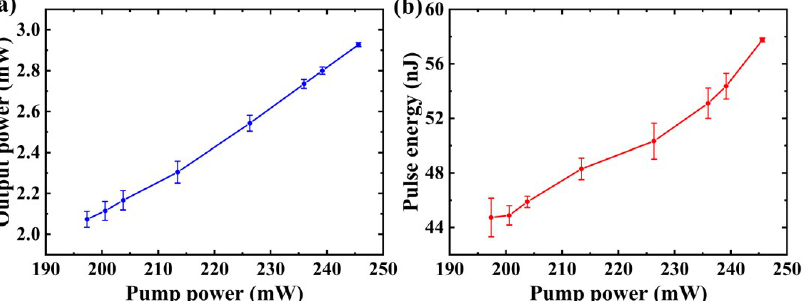
Figure 7. Q-switched laser features for different pump powers. ( a ) Average output power as a function of pump power. ( b ) Measured pulse energy as a function of pump power.